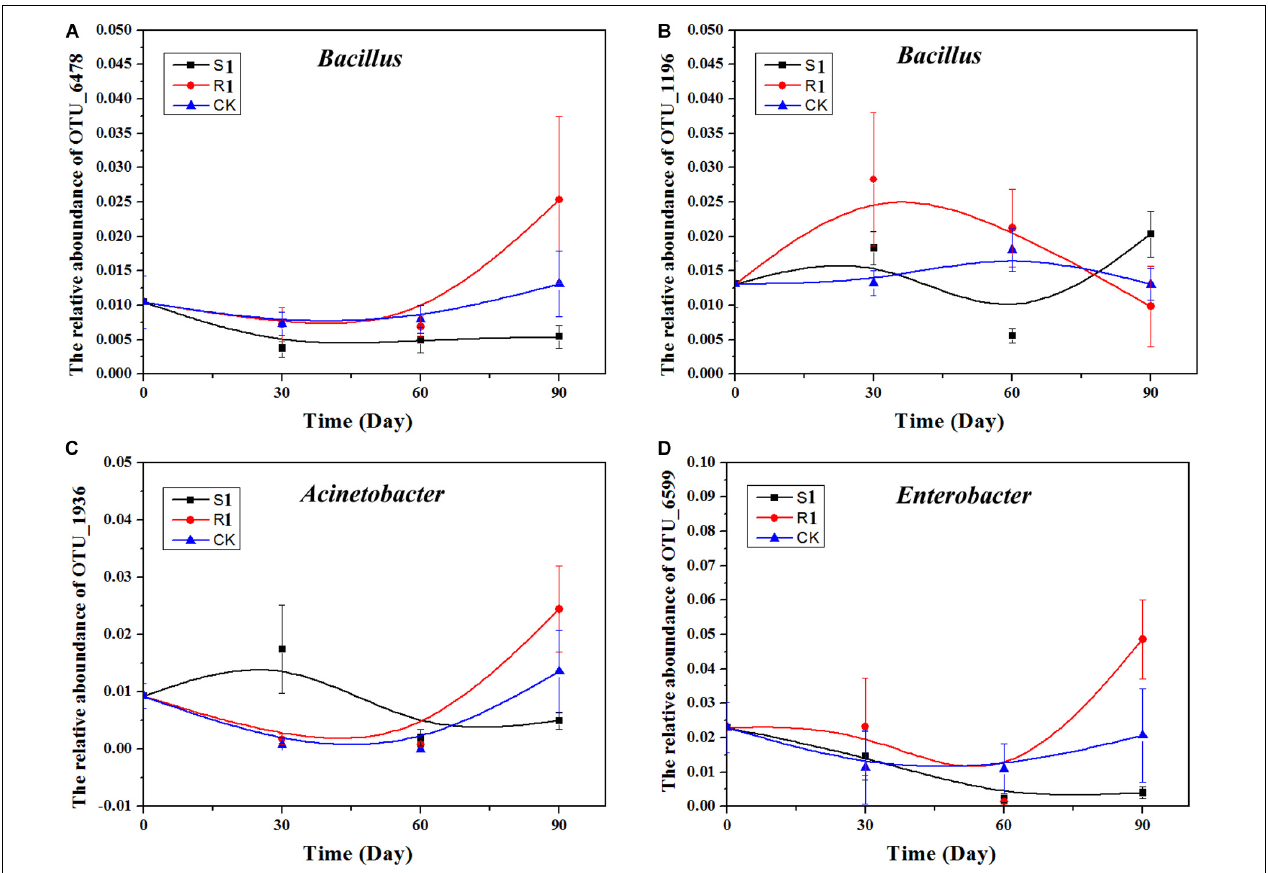
FIGURE 6 | Relative abundance of four OTUs over time: (A) Acinetobacter, (B) Enterobacter, (C) Bacillus ; (D) Stenotrophomonas . CK, control group ( N = 8); R1, treatment with functional microflora R1 ( N = 8); S1, treatment with functional microflora S1 ( N =